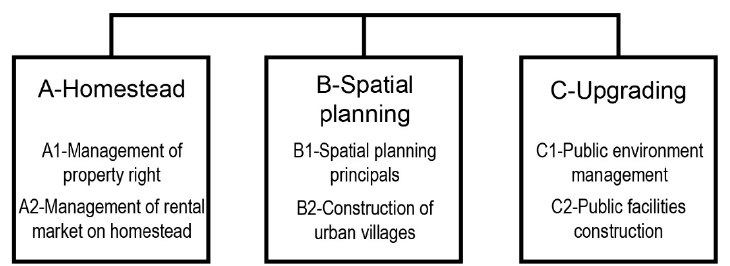
Figure 6. Three dimensions and six sub-classifications for policy analysis. This article calculates the frequency of each keyword/phrase and its frequency distri- bution according to the urbanization stages and implementation approaches. The results are shown in Figure